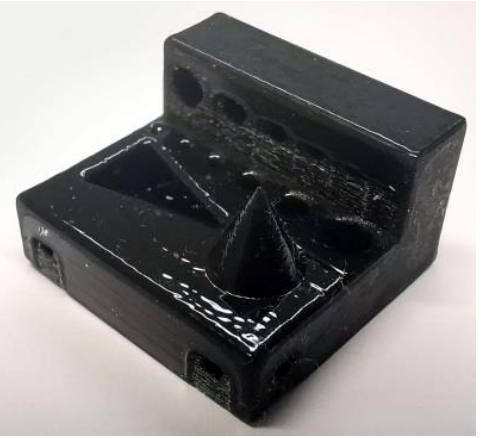
Figure 5. Printed test plate.